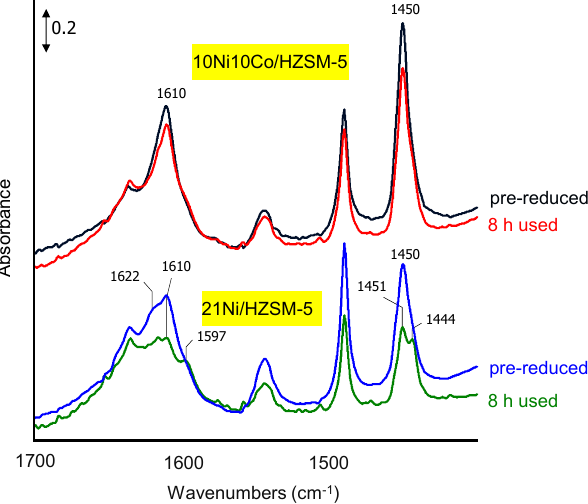
Figure 3. Infrared spectra of adsorbed pyridine (pyr-IR spectra) of pre-reduced and spent HZSM-5-supported catalysts (after 8 h on-stream).